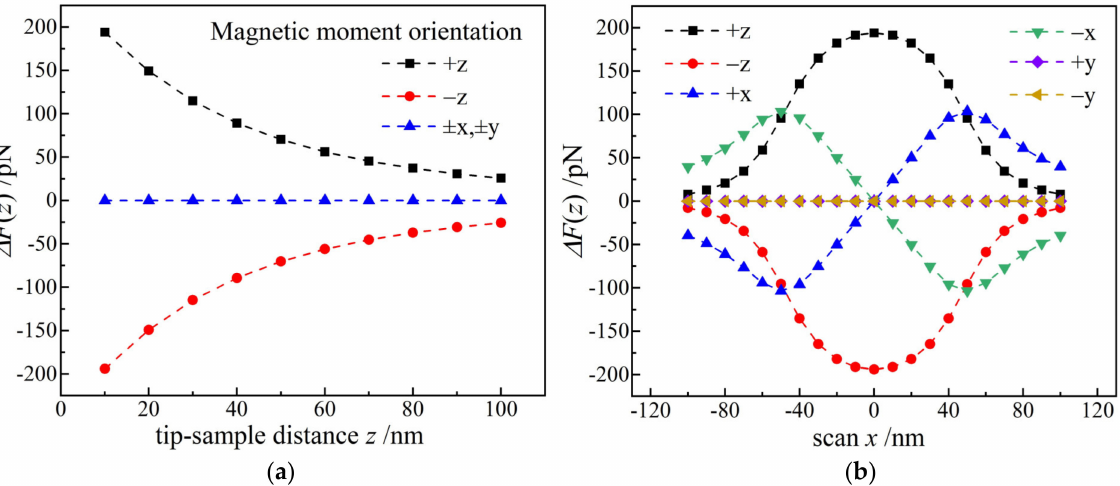
Figure 3. Probe magnetic force varying with ( a ) vertical and ( b ) horizontal scanning distance x for ferromagnetic single-domains ( D = 100 nm, h = 100 nm) with different magnetic moment